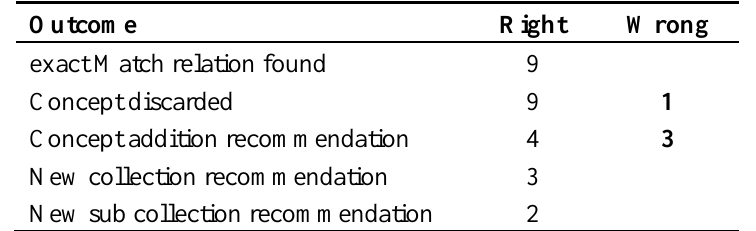
Table 13. Summary results of the matching process between P and U .